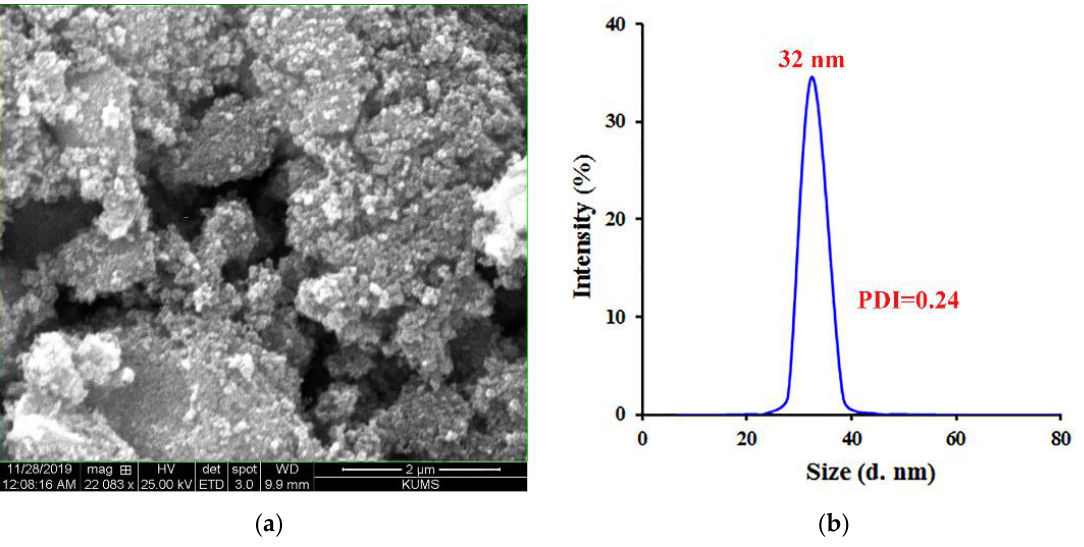
Figure 1. The ( a ) SEM image and ( b ) DLS analysis of Fe 3 O 4 NPs.